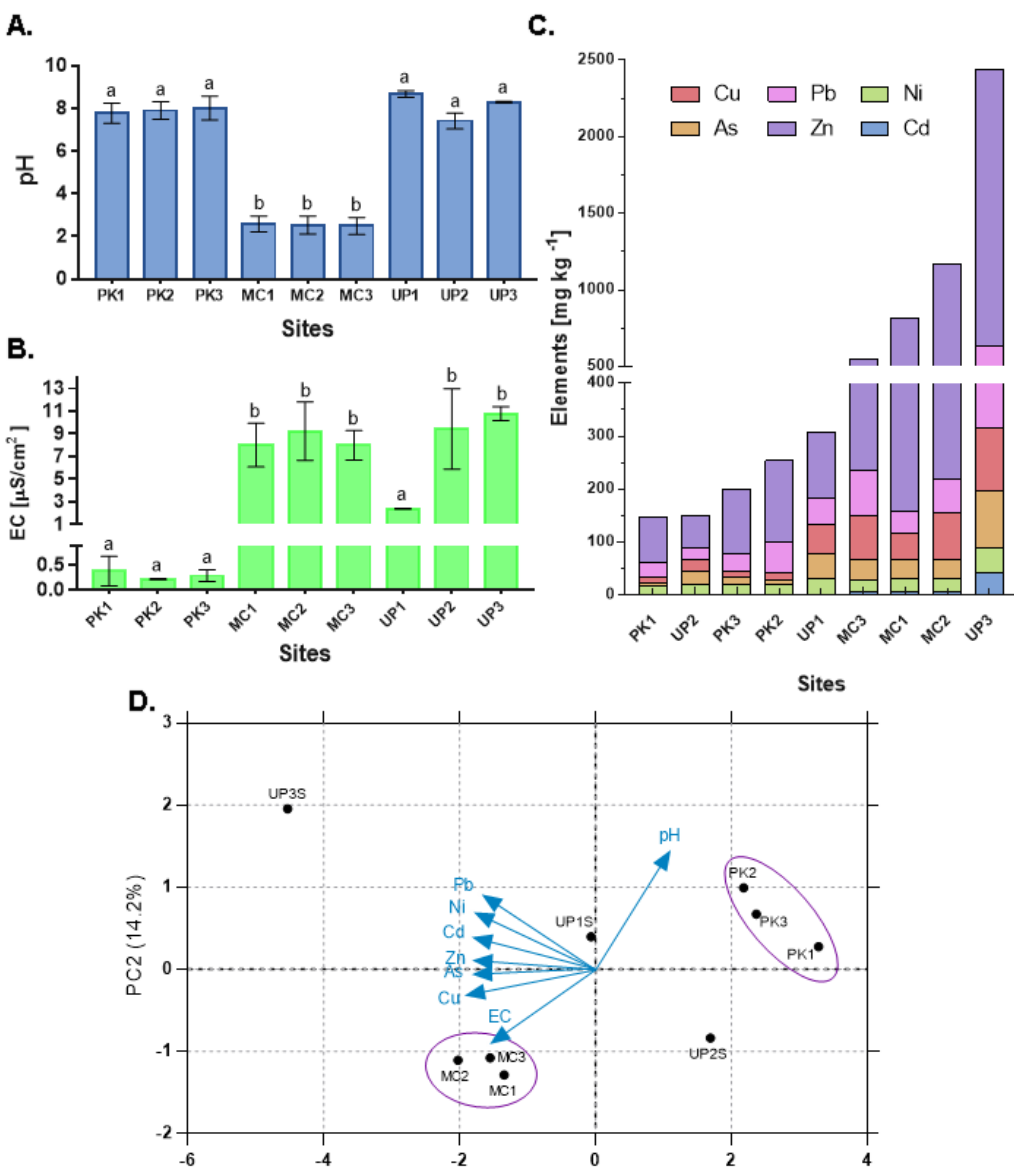
Figure 2. Physicochemical parameters and metal levels. The mean values are shown in bars, and standard deviation values are presented as the error-bars. Different letters represent statistically significant differences ( p < 0.05), calculated by analysis of variance (ANOVA). ( A ) pH and ( B ) EC of water. ( C ) The levels of metals (mg Kg − 1 ) measured from sediment samples. The data is shown in bars with cumulative values. ( D ) PCA of physicochemical parameters and metal concentrations of sampling sites.